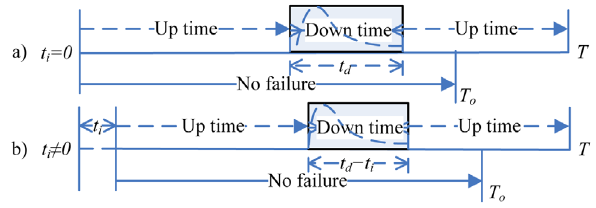
Figure 2. Schematic figure of the proposed mission availability